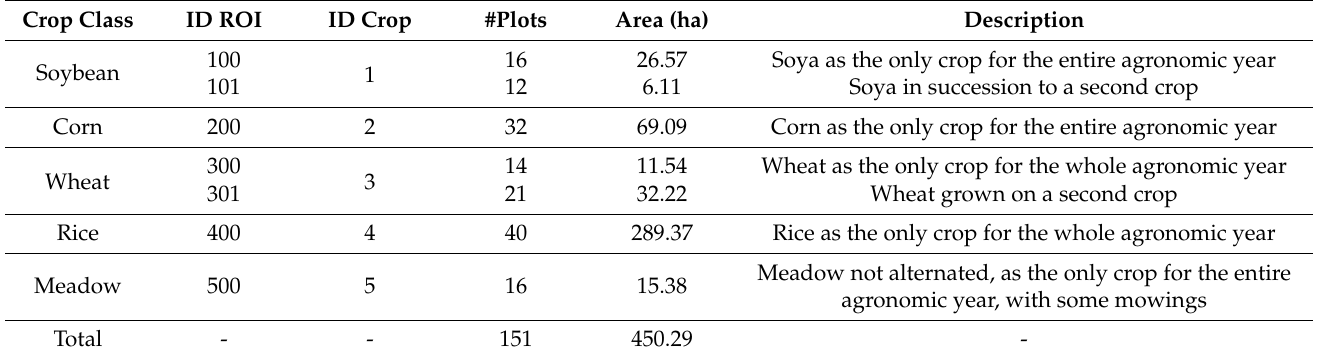
Table 6. Characteristics of ROI.